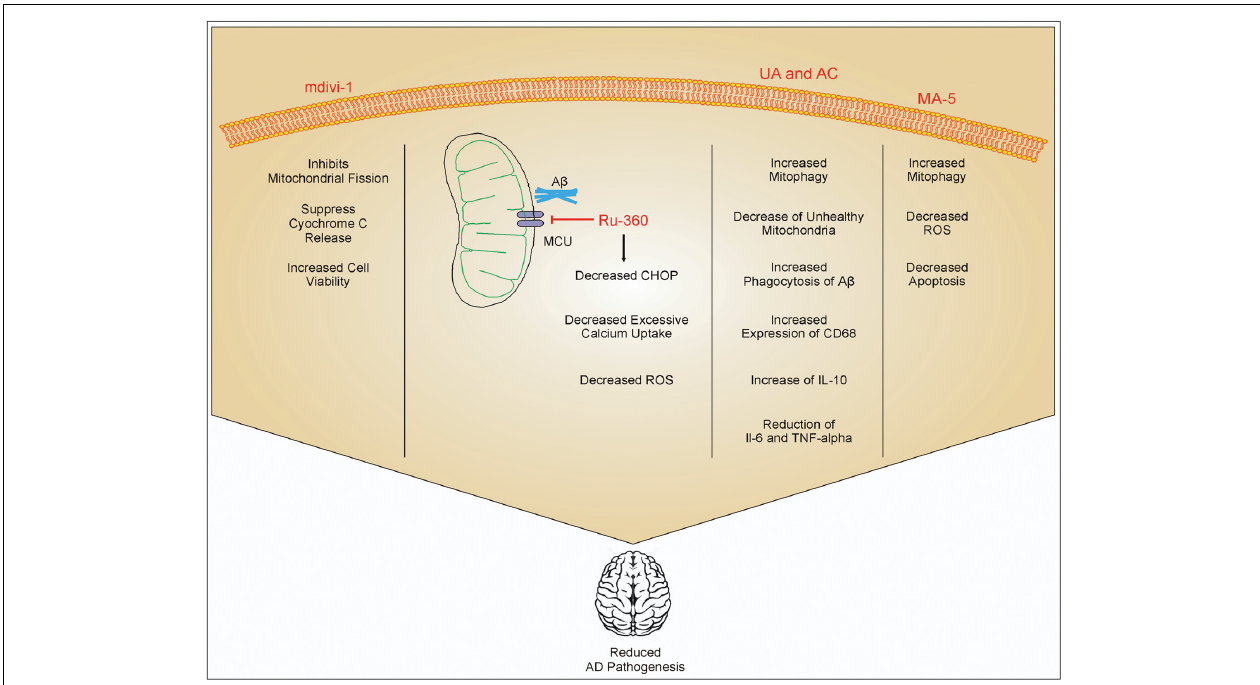
FIGURE 2 | Role of different drugs in improving AD pathology. mdivi-1 inhibits mitochondrial fission and inhibits the release of cytc, which in turn increases cell viability. Ru-360 decreases excessive calcium uptake by mitochondria and reduces the expression of C/-EBP homologous protein (CHOP) on the endoplasmic reticulum. This inhibits ROS production. Urolithin A (UA) and actinonin (AC) increases phagocytosis of A β and increases mitophagy which reduces the number of damaged mitochondria inside cells. UA and AC also increase the expression of IL-10 and inhibit IL-6 and TNF- α . Mitochonic acid 5 (MA-5) also increases mitophagy and decreases the production of ROS. These drug effects enhanced cell viability, and reduced inflammation and AD pathology.